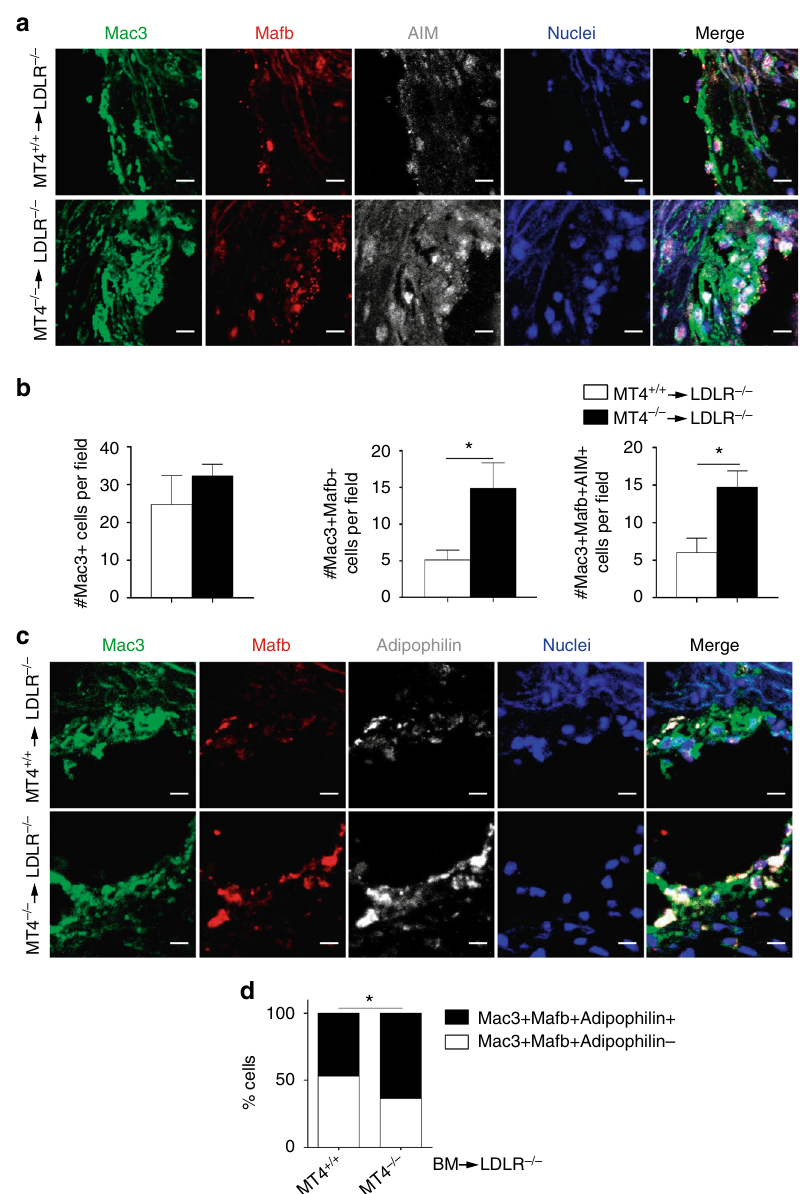
Fig. 6 Lack of MT4-MMP in patrolling monocytes leads to the accumulation of Mafb + AIM + macrophages in incipient atherosclerotic plaques. a Representative images of transverse sections of aortic sinus from Ldlr – / – mice transplanted with MT4-MMP + / + (MT4 + / + ) or MT4-MMP – / – (MT4 – / – ) BM cells and fed a HFD for 1 week; sections were labeled for Mac3 (green), Mafb (red), and AIM (white), and with Hoechst (blue; nuclei); scale bar, 10 µ m. b Number of Mac3 + cells (left), Mac3 + Mafb + cells (middle), and Mac3 + Mafb + AIM + cells (right) in the plaques of BM-transplanted Ldlr – / – mice fed a HFD for 1 week. c Representative images of transverse sections of aortic sinus from BM-transplanted Ldlr – / – mice fed a HFD for 1 week; sections were labeled for Mac3 (green), Mafb (red), and adipophilin (white), and with Hoechst (blue; nuclei); scale bar, 10 µ m. d Relative % of adipophilin-positive and adipophilin-negative cells within the Mac3 + Mafb + population of BM-transplanted Ldlr – / – mice (1 week on HFD); n = 7 mice per genotype in two independent experiments. Data were tested by two-tailed Student ’ s t -test in b and by Fisher ’ s exact test in d . Results are expressed as mean ± SEM. * p <